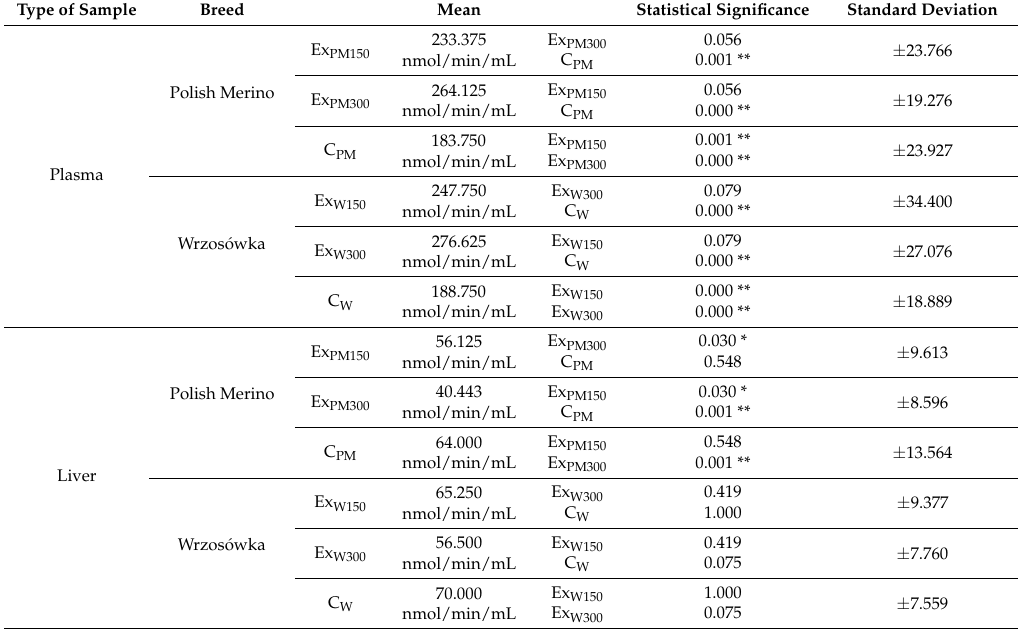
Table 3. Activity of glutathione peroxidase (nmol/min/mL) in plasma and liver samples collected from both breeds as affected by the dose of the